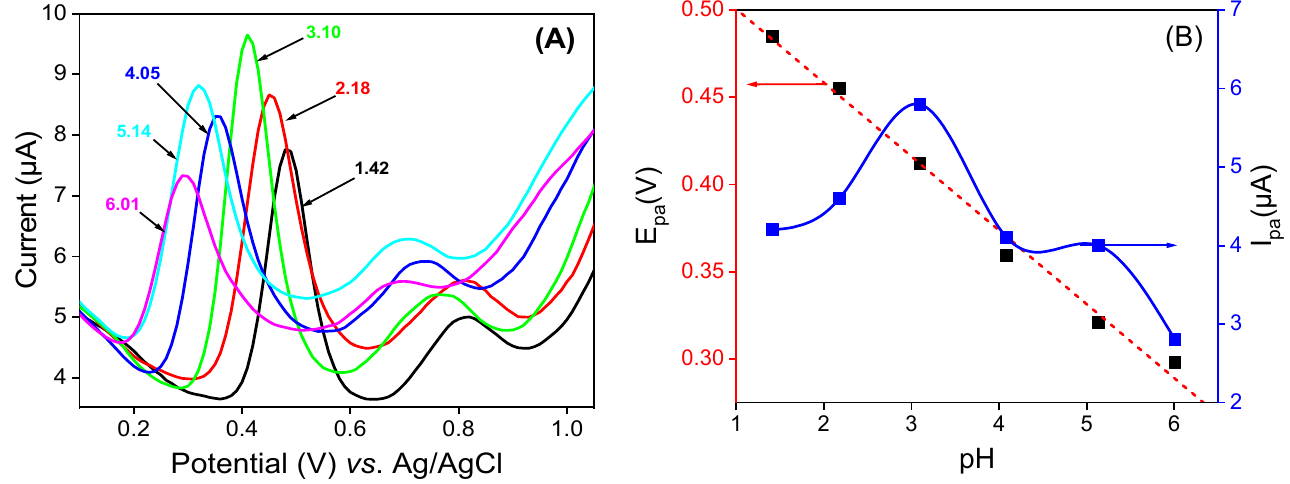
Figure 7. ( A ) Variation in pH values of (v/v) phosphate buffer and EtOH mixture solution on LaNH 3 + /GCE in the presence of 10 − 4 M of QCT. ( B ) The curves of i pa = f (pH) and Epa = f(pH).